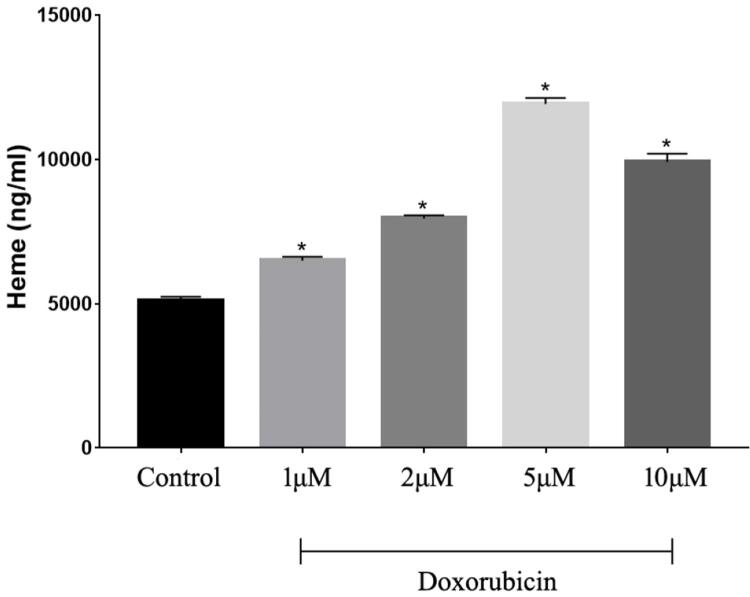
Effects of doxorubicin on heme levels in H9c2 cells exposed to saline (control group) or doxorubicin with different concentrations for 24 hours. Heme levels were measured by ELISA. Data are presented as the mean±standard deviation. *p<0.01, compared with the control group.